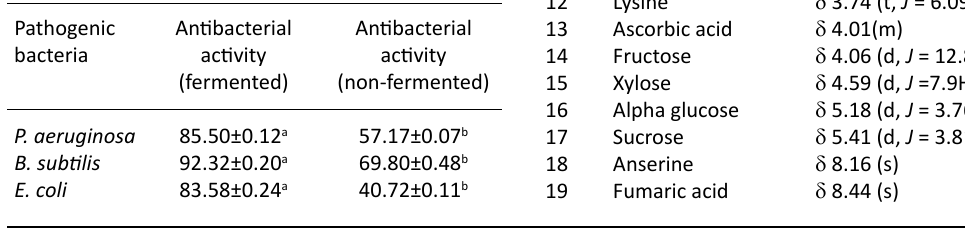
table 1. Antibacterial activity of fermented and non- fermented Cyperus rotundus extract Pathogenic Antibacterial Antibacterial bacteria activity activity (fermented) (non-fermented)